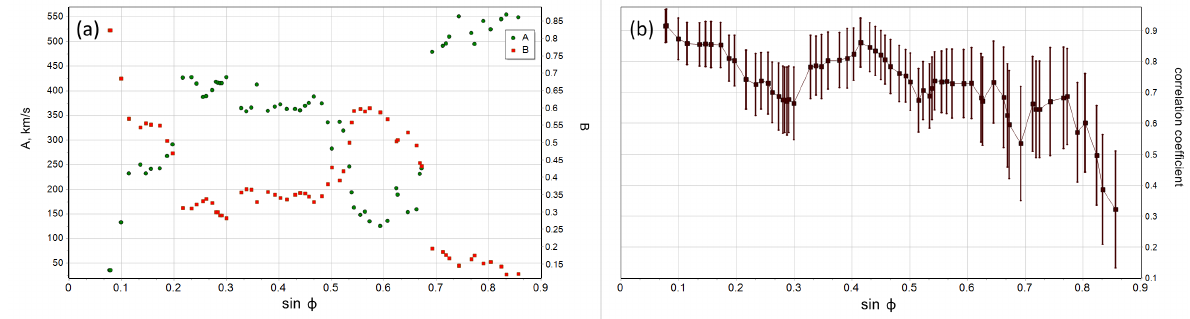
Figure 4. Distribution of the regression coefficients ( a ) and the correlation coefficients ( b ) depending on sin φ